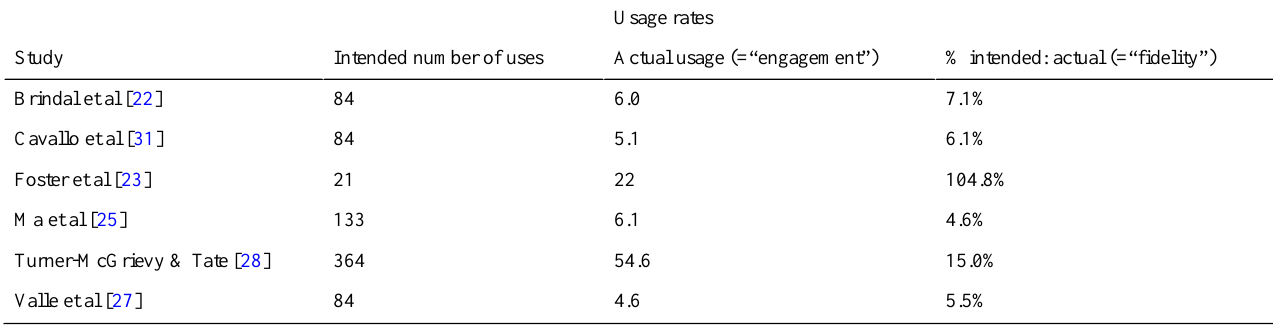
Table 3. Summary of engagement and fidelity with the